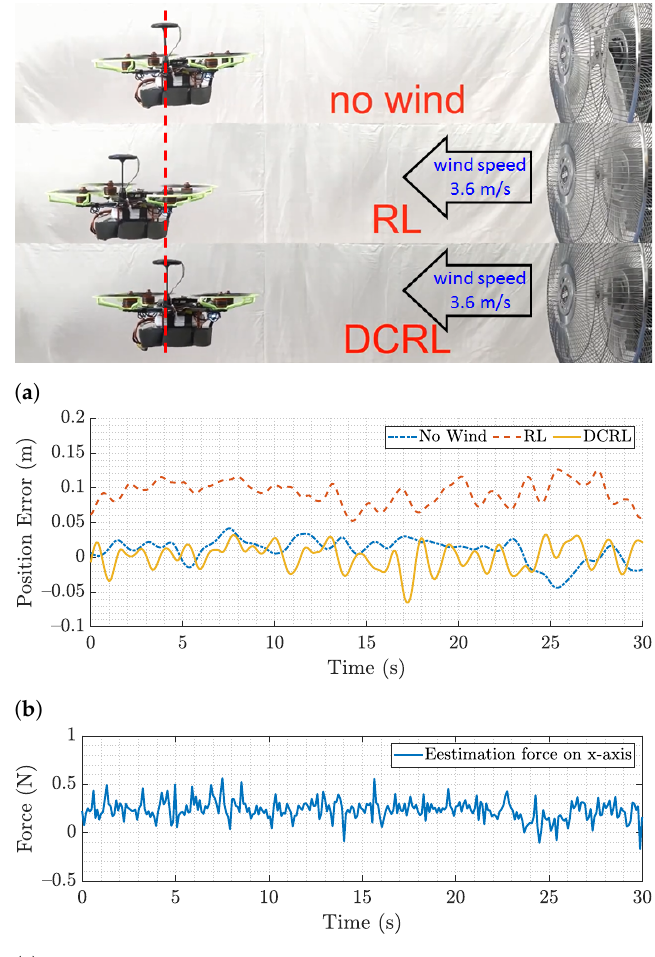
Figure 6. ( a ) The indoor fix-position hover experiment setup. An electric fan was used for simulating a constant wind disturbance with wind speed 3.6 m/s applied onto quadrotor x -axis. ( b ) The position error along x -axis. ( c ) The estimation of external force on x -axis.